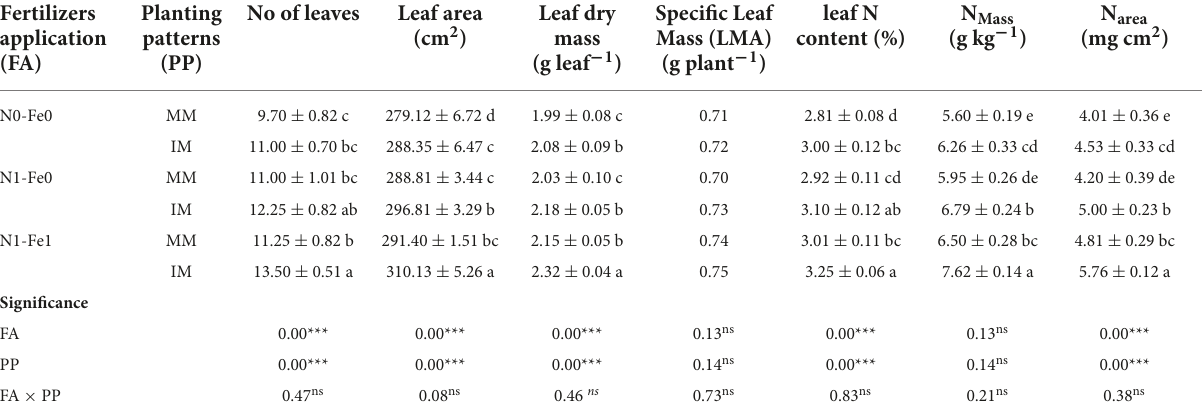
TABLE 3 Leaf characteristics of maize crops as affected by nitrogen and iron fertilization under different planting patterns. Fertilizers